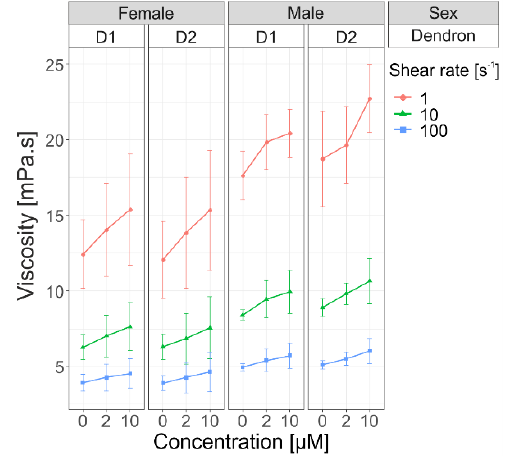
Figure 6. Three − factor ANOVA comparison of viscosities of two amphiphilic phosphorous dendrons (D1 vs. D2). Viscosity was measured at three different concentrations (c 0 = 0 µ M, c 1 = 2 µ M, c 2 = 10 µ M) at three different shear rates (1 s − 1 , 10 s − 1 , and 100 s − 1 ) for males (n = 6) and females (n = 6) at 37 ◦ C. The symbols represent the group means at each level of shear rate, while the error bars represent the standard deviation of the underlying data distribution.